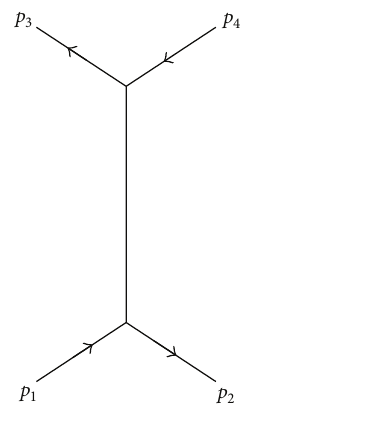
Figure 1: The geometry of the annihilation-creation